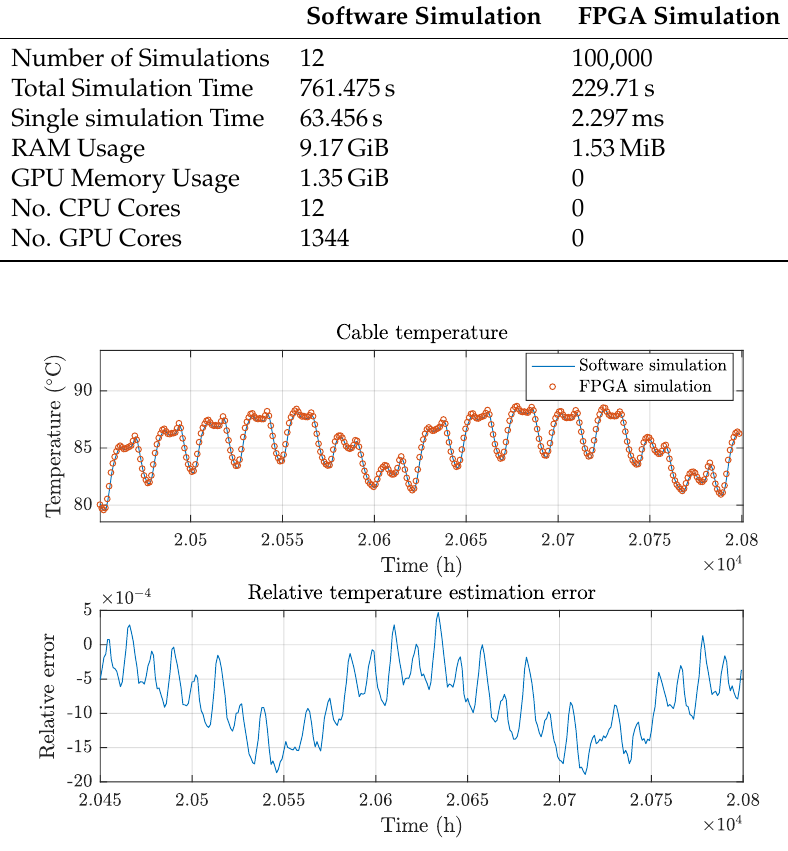
Figure 19. FPGA temperature estimation results compared to software